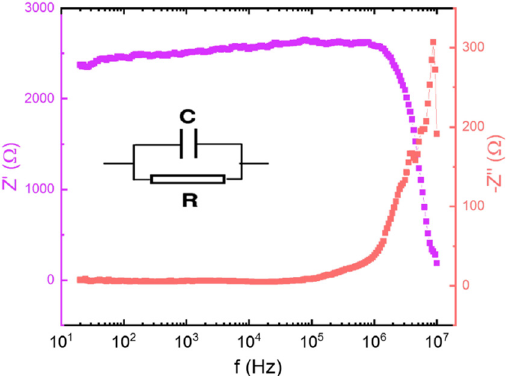
(30 min)/ZnO/glass sample 2